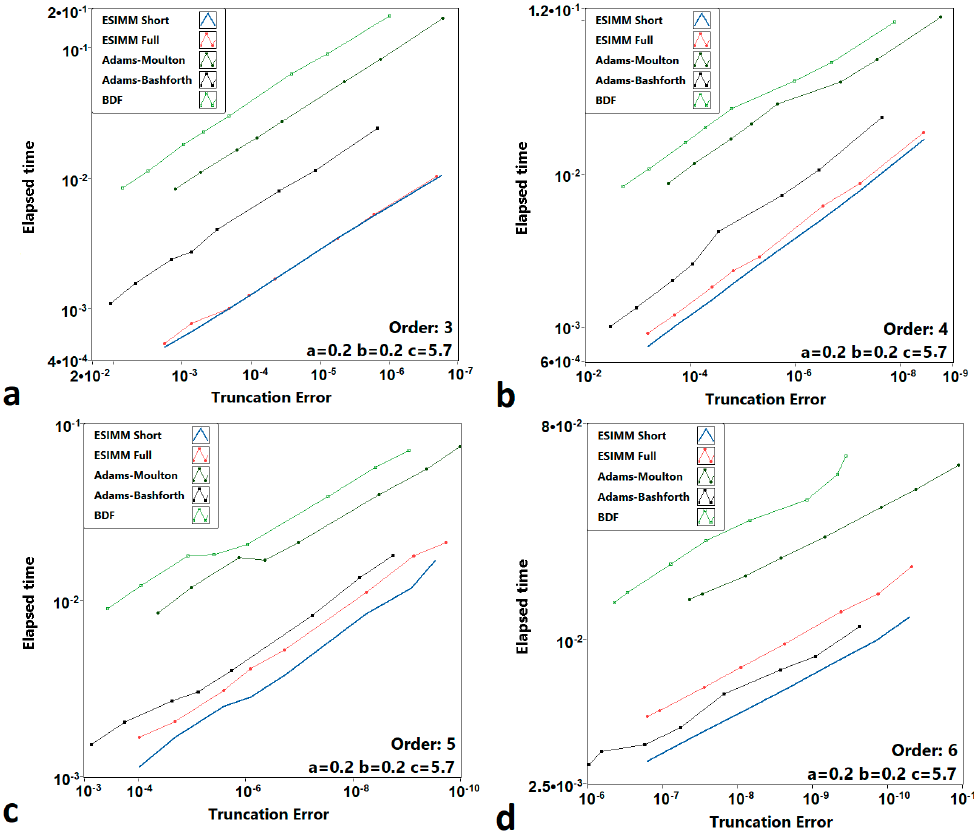
Figure 3. Performance plots obtained while simulating Rossler systems by various multistep methods with the accuracy ( a ) order 3, ( b ) order 4, ( c ) order 5 and ( d ) order 6.